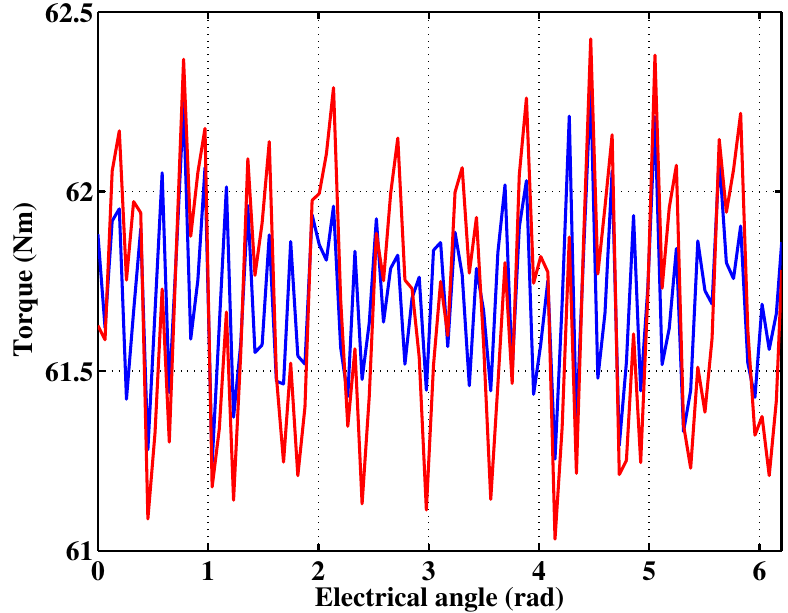
Figure 16. Zoom view of the torque-angle characteristics of Figure